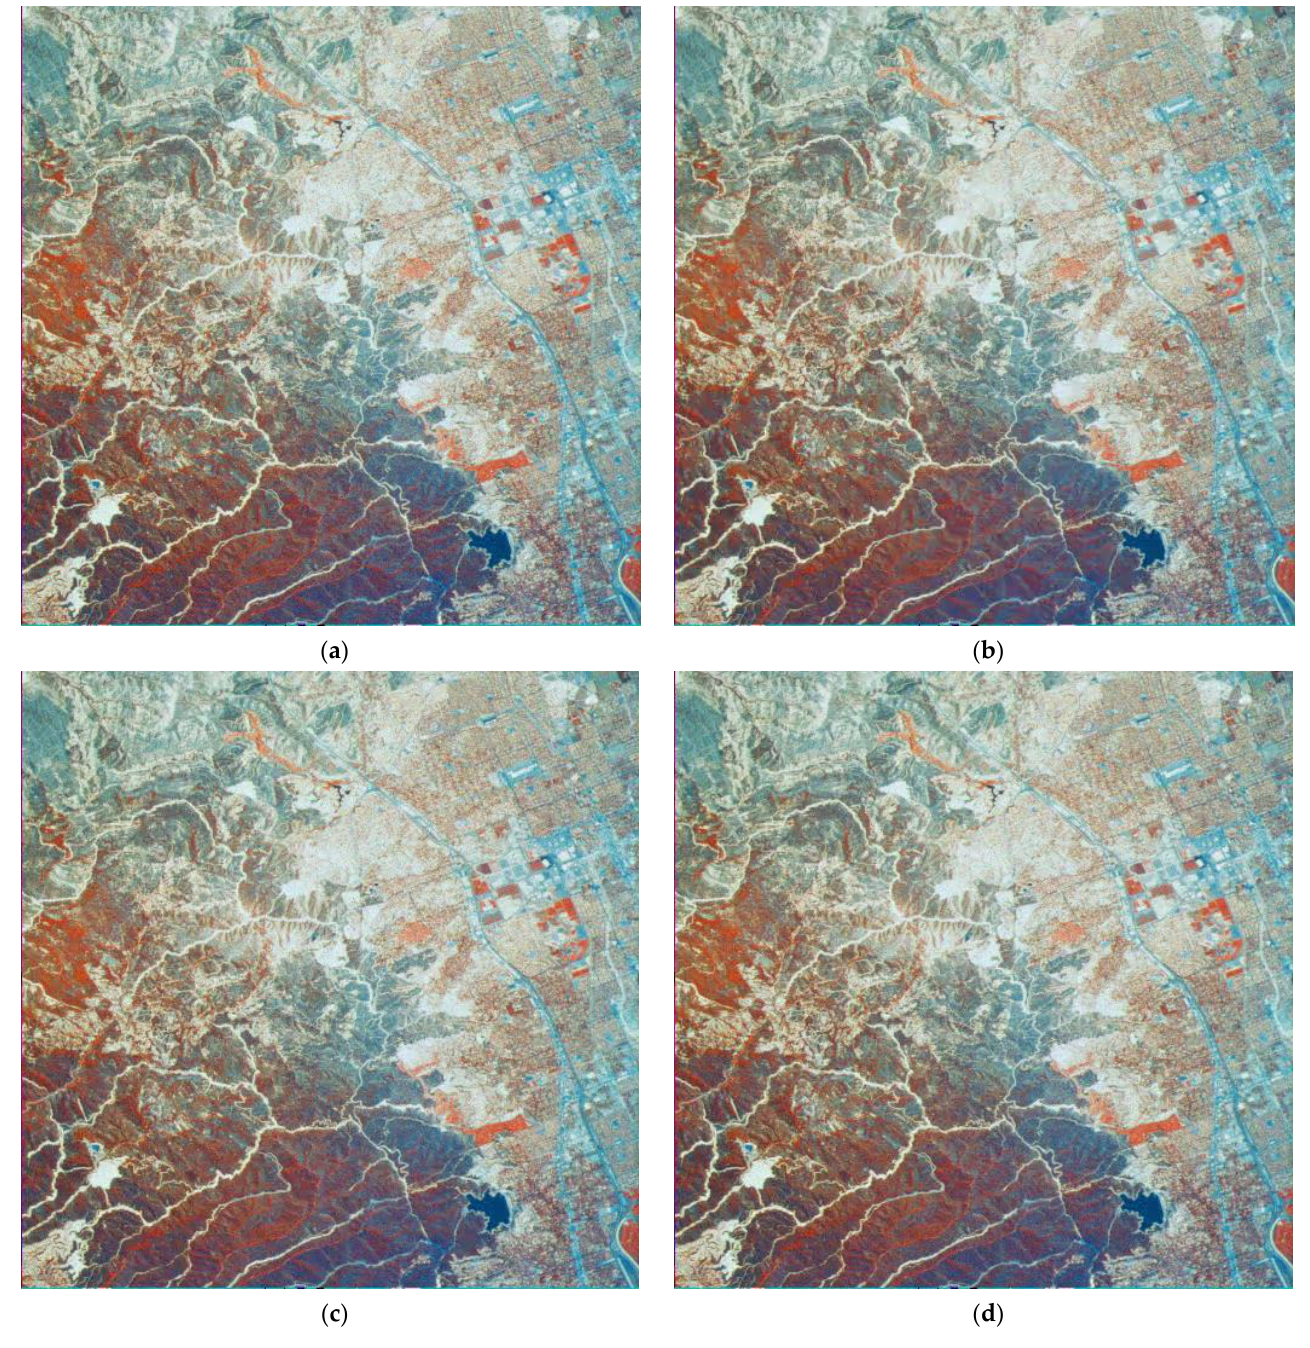
Figure 11. Original (noisy) image ( a ) and images compressed in Q = 33 (true ∆𝑃𝑆𝑁𝑅 − 𝐻𝐴 = − 1.8, predicted ∆𝑃𝑆𝑁𝑅 − 𝐻𝐴 = −1.7, true ∆𝑀𝐷𝑆𝐼 = 0.033, predicted ∆𝑀𝐷𝑆𝐼 = 0.021 ) ( b ), Q = 31 ( c ), and Q = 29 ( d ) for the format 4:4:4; thus, compression with Q smaller than Q OOP is needed.